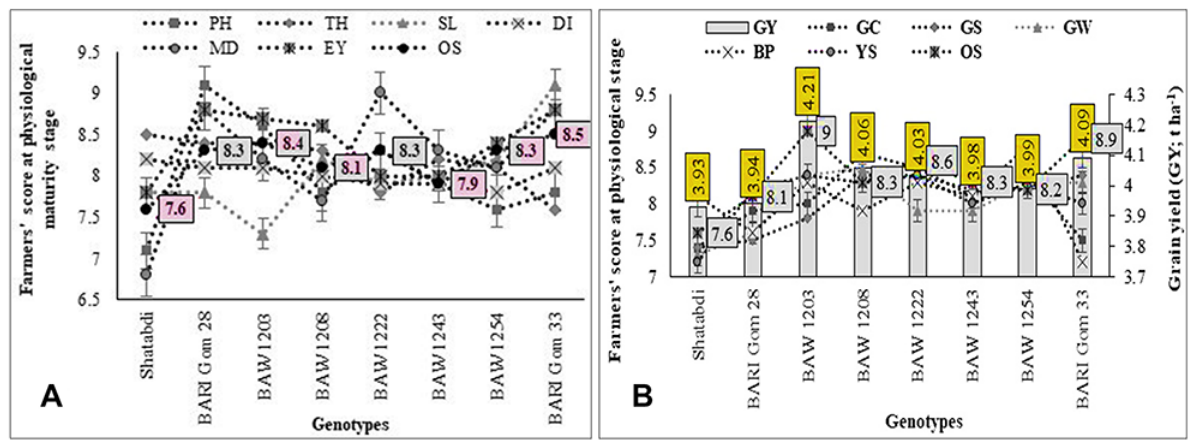
Fig. 4 Farmers’ preference scores for different traits of seven selected wheat genotypes including ‘BARI Gom 33’ applying a participatory varietal selection method during the 2016–2017 season. PH – plant height; TH – tillering habit; SL – spike length; DI – disease incidence; MD – maturity days; EY – expected yield; OS – overall score; GC – grain color; GS – grain size; GW – grain weight; BP – black point; YS – score on yield basis; GY – grain yield. Data source: [60].